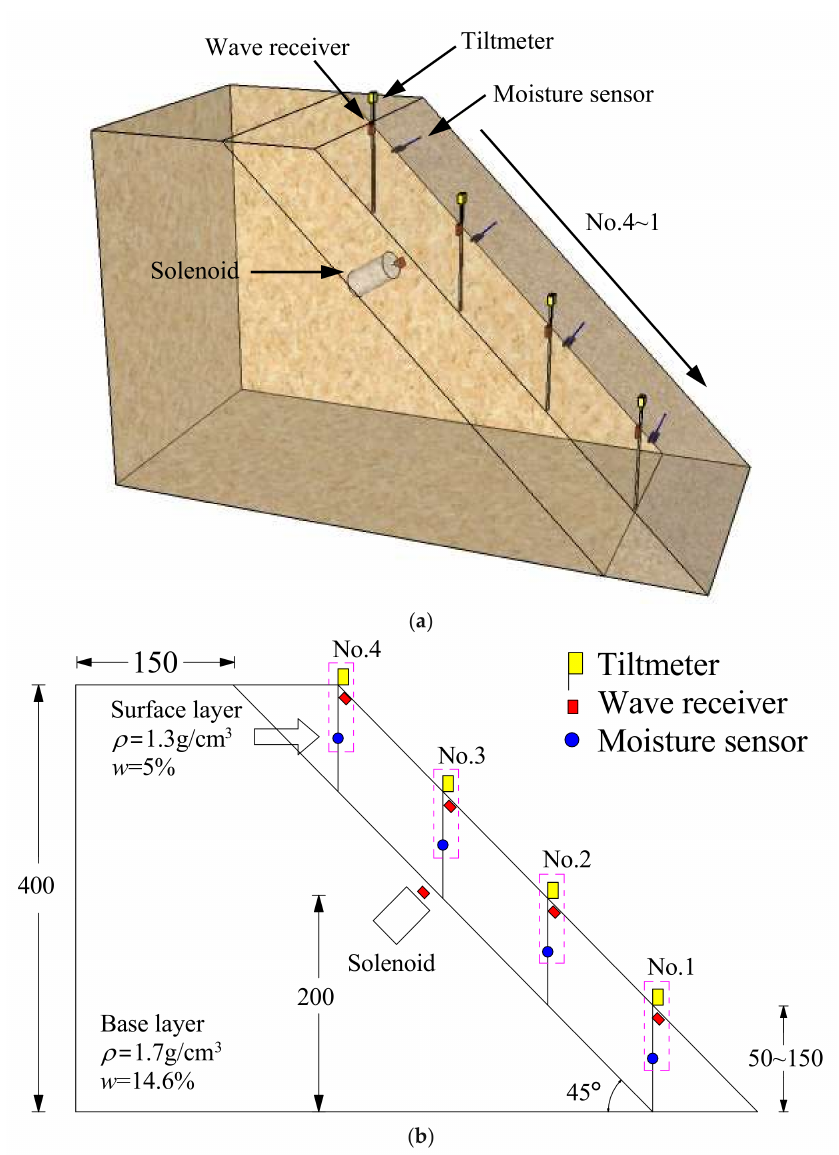
Figure 2. Schematic illustration of the fixed slope model. ( a ) 3-D illustration; ( b ) Scaled 2-D model (unit: